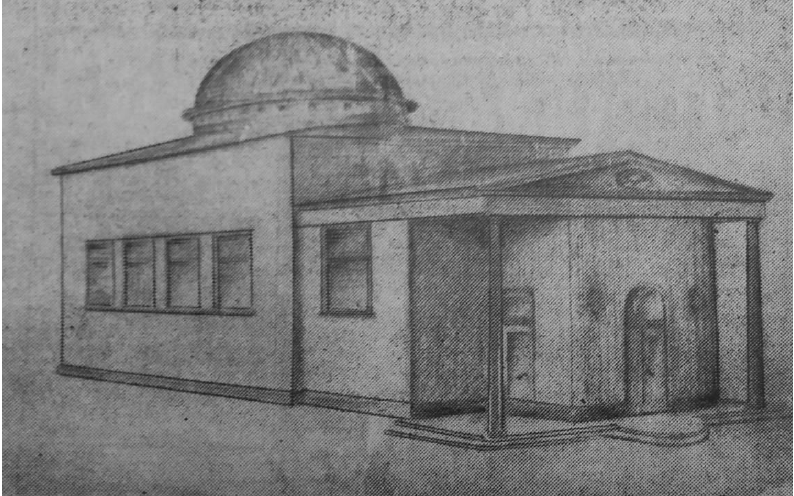
Figure 15. Design for a synagogue in Bulduri, perspective view by B. Kļaviņš, 1937 ( Segodnia vecherom 1937).